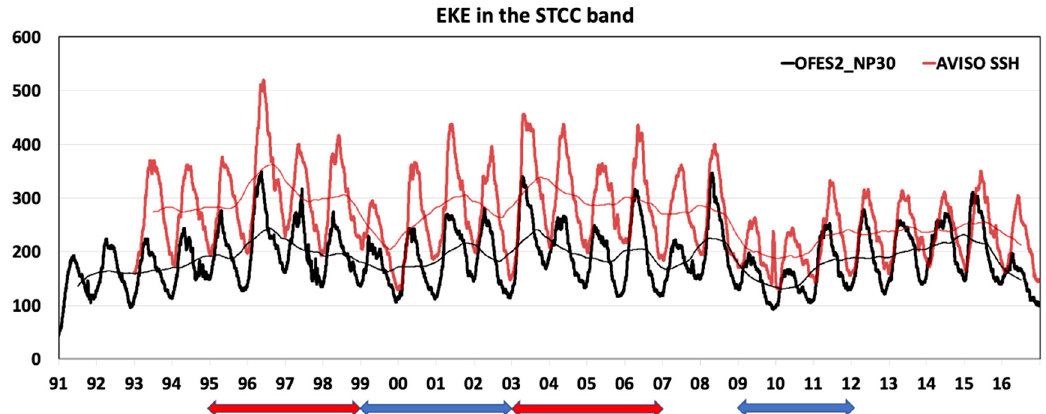
Figure 2. Time series of daily mean (thick curves) and annual running mean (thin curves) EKE (cm 2 s − 2 ) in the STCC region in OFES2_NP30 (black curves) and the AVISO satellite observations (red curves). Qiu and Chen (2013) [14] showed that the EKE within the 18 ◦ –28 ◦ N in the Northwestern Pacific including the STCC and Hawaiian Lee Countercurrent (HLCC) were high in 1995–1998 and 2003–2006 (red arrows) and low in 1999–2002 and 2009–2011 (blue arrows).